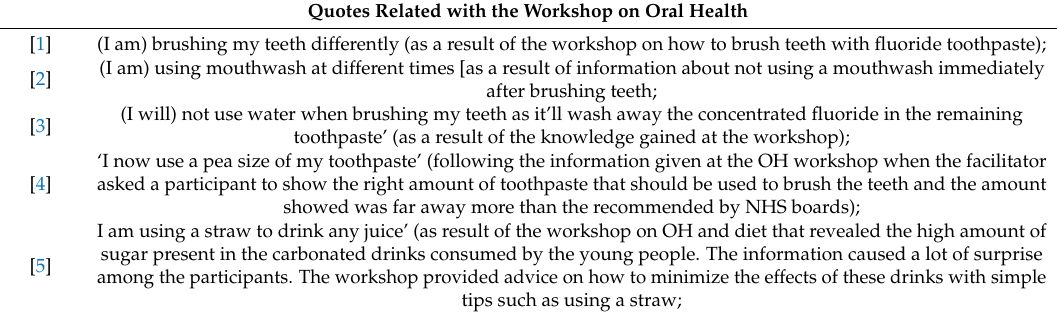
Table 3. Consensus building and joint action plans for oral health (OH) behavior change following OH